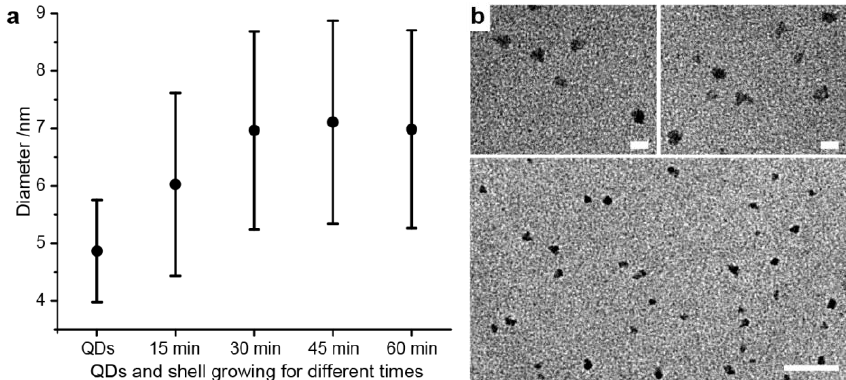
Figure 2. ( a ) Size analysis for quantum dots (QDs) without conjugation shells and QDs incubated with DNA, Zn(NO 3 ) 2 , and 3-mercaptopropionic acid (MPA) for different times; ( b ) Transmission electron microscopy images for PTO-DNA-modified CdSeS/ZnS after 30-min incubation at 90 °C. Scale bars: 10 nm (upper panels) and 50 nm (lower panel). TEM images for QDs incubated for different times are included in the supporting information (Figures S2–S4).